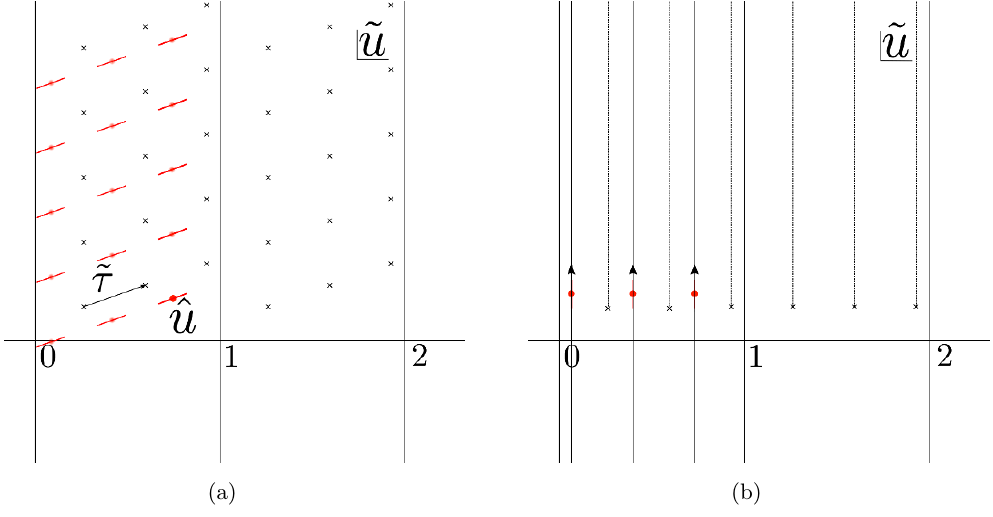
with non trivial ( q; p ), at (cid:12)nite (cid:28) . e g